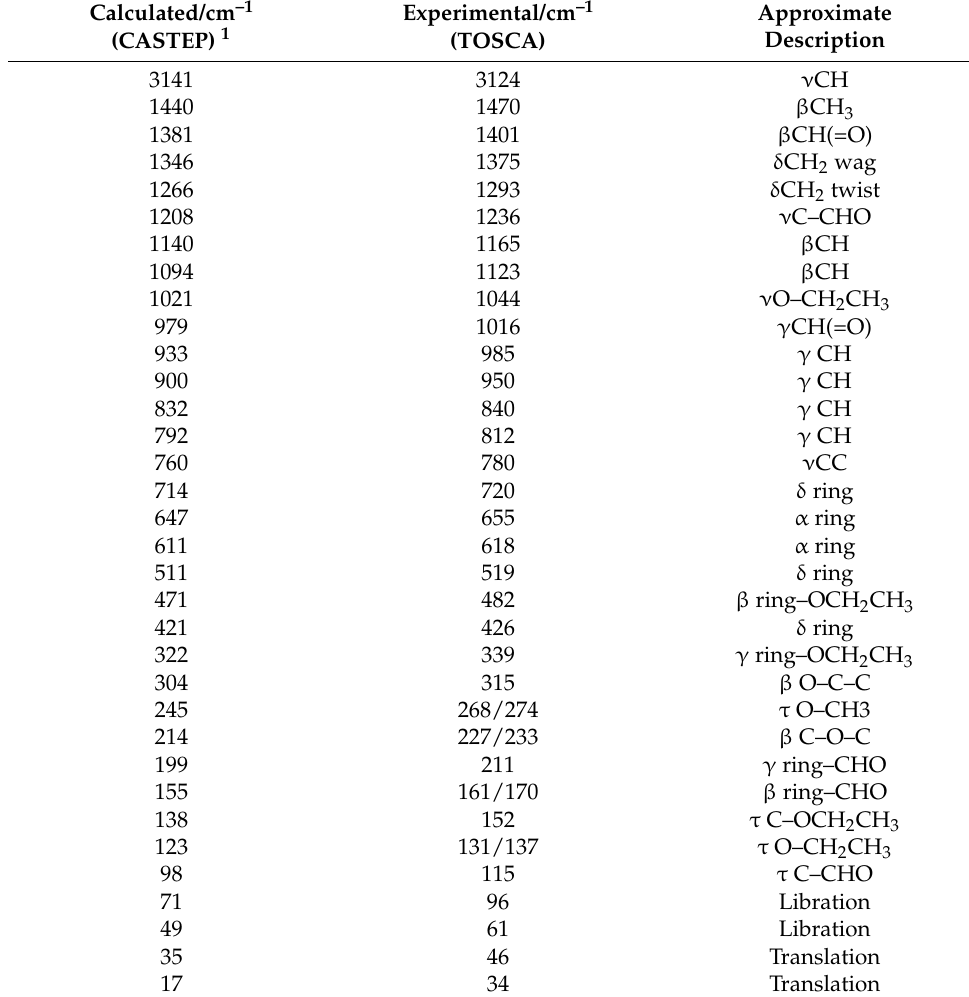
Figure 5. The INS spectra of 4EtOB up to 1800 cm − 1 : experimental ( top ) and simulated from periodic calculations ( bottom , CASTEP). The theoretical spectra were calculated at the Γ -point and averaged by the dispersion throughout the Brillouin zone (BZ). The full INS spectra, up to 4000 cm − 1 , the comparison between periodic and discrete calculations at the same level are shown in Figures S1 and S2, Supplementary Material, respectively. The inset presents the Far-IR spectra in the 25–550 cm − 1 range: experimental ( top ) and simulated from periodic calculations ( bottom , CASTEP). Table 6. Experimental and calculated INS maxima for 4EtOB with mode assignment.